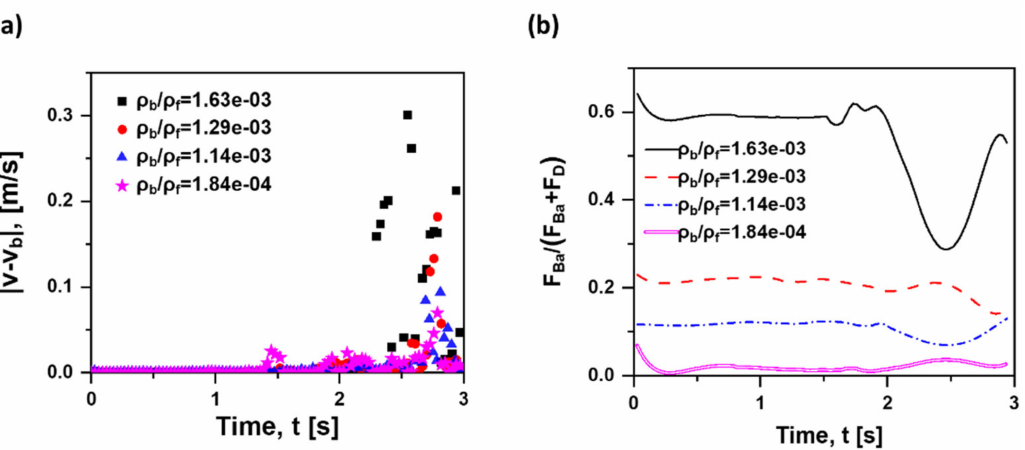
→ → → → → F Ba /( F D + F Ba ) and | F Ba / F B | over time at four diameters. ( v 0 = 0 m/s,